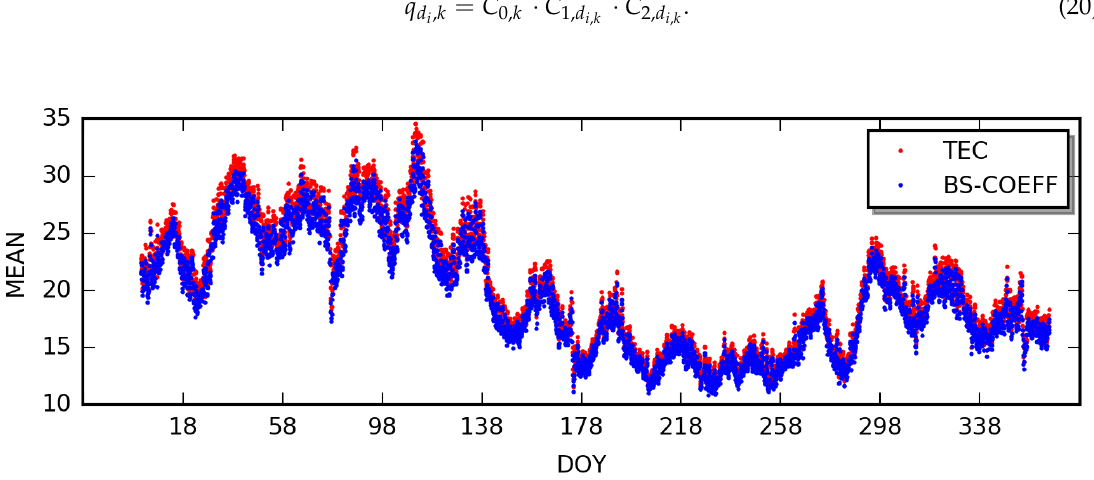
Figure 2. Correlation analysis of global mean values of VTEC maps and B-spline coefficients; the mean values of the IGS VTEC maps computed with a 2 h temporal resolution during the year 2015 (red dots) as well as the mean values of estimated B-spline coefficients maps (blue